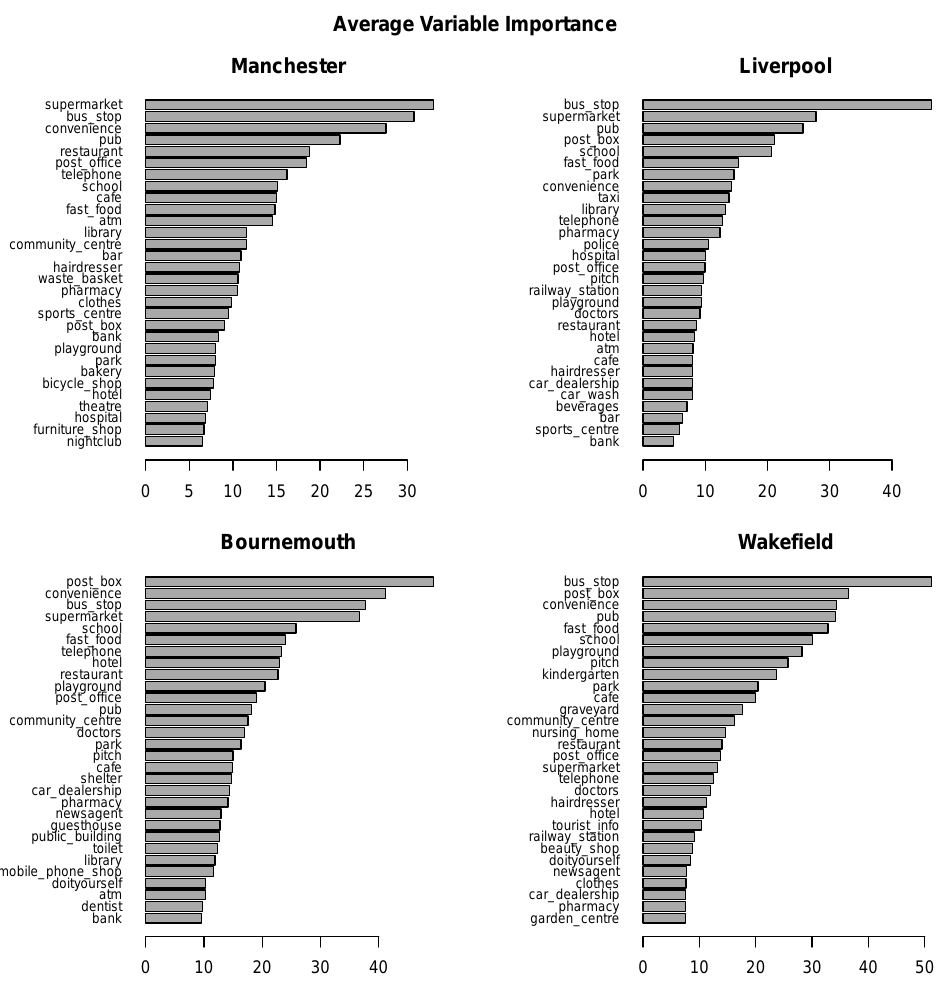
Figure 10. The average variable importance plots for crime risk